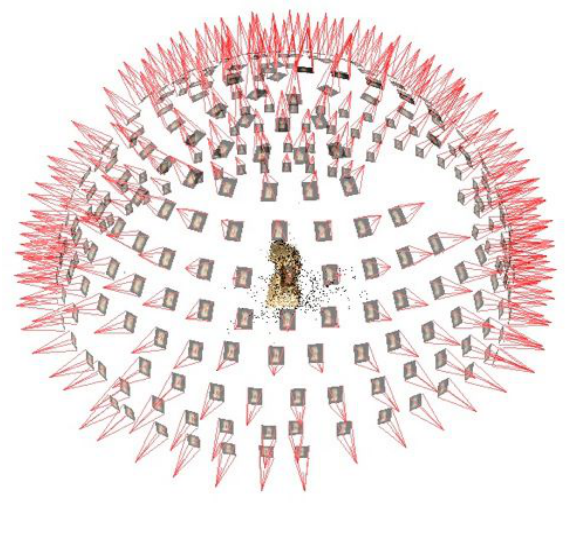
Figure 1: An example of structure and motion (cameras) pro- duced by